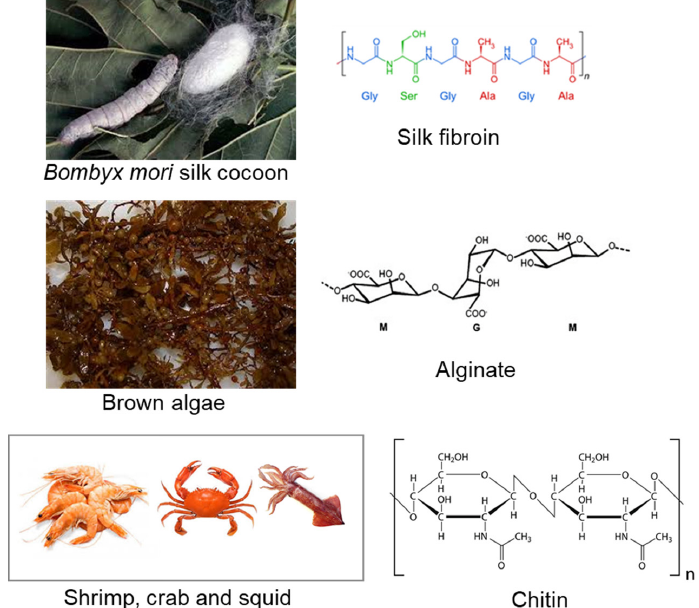
Figure 1. Some biopolymers derived from renewable resources and respective chemical structures: silk fibroin, alginate, and chitin.